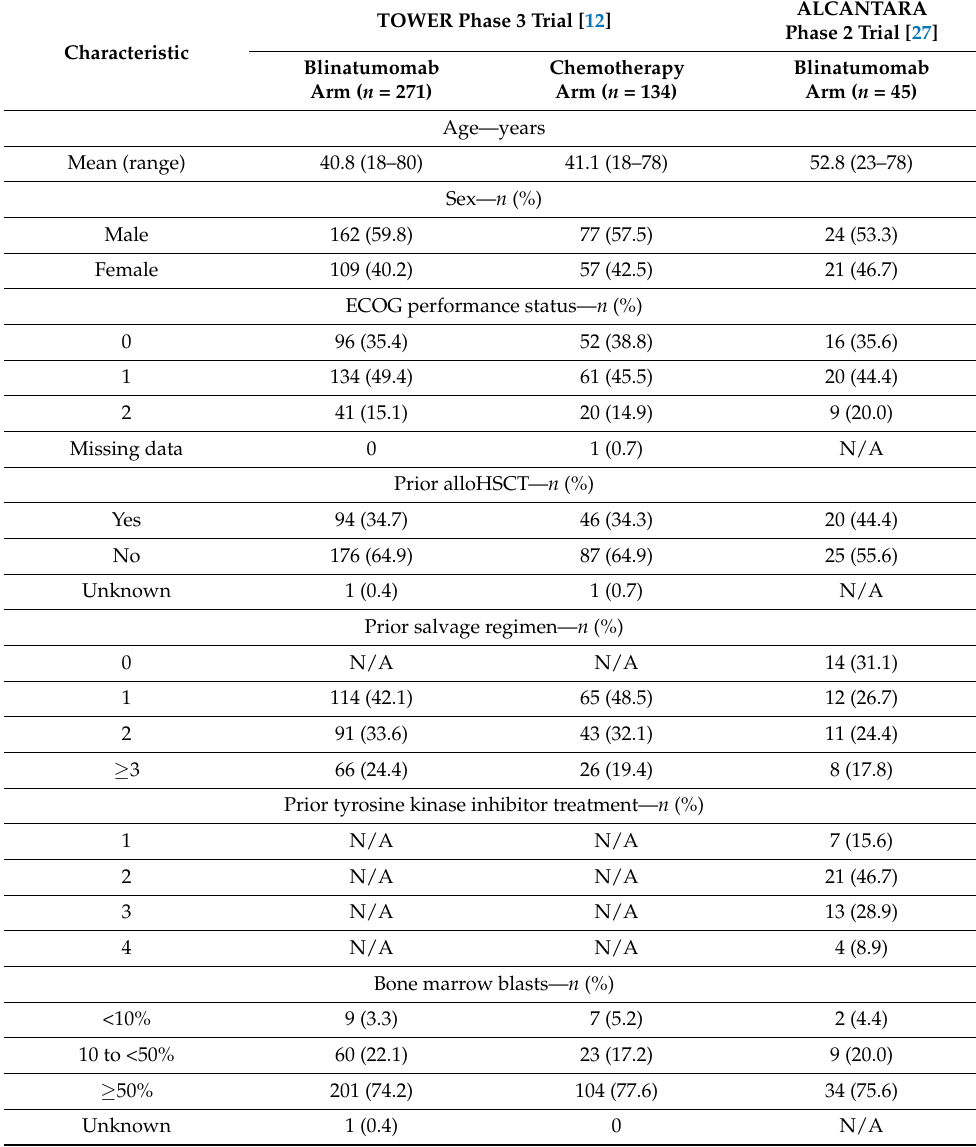
Table 1. Demographic and baseline clinical characteristics of patients in the phase 3 TOWER and phase 2 ALCANTARA clinical